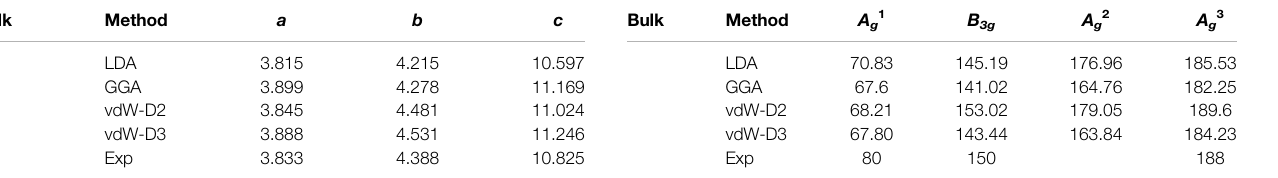
TABLE 1 | The calculated structure lattice parameters (in the unit of Å) of bulk GeSe with various methods. Bulk